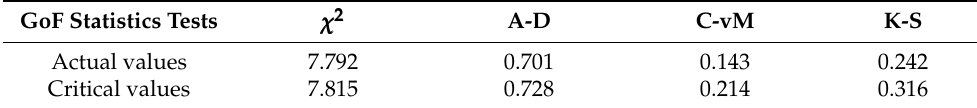
Table 5. Goodness-of-fit statistics tests results for the specimens of 3 mm in diameter.